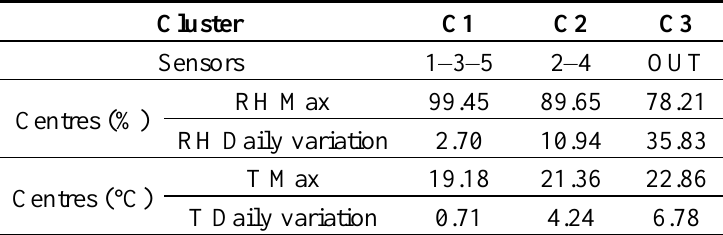
Table 3. Results of cluster analysis of data recorded after installing the expanded clay and geotextile (from 13 August 2013 to 8 October 2013, from 00.00 to 23.59 h; 2,688 data points/sensor).